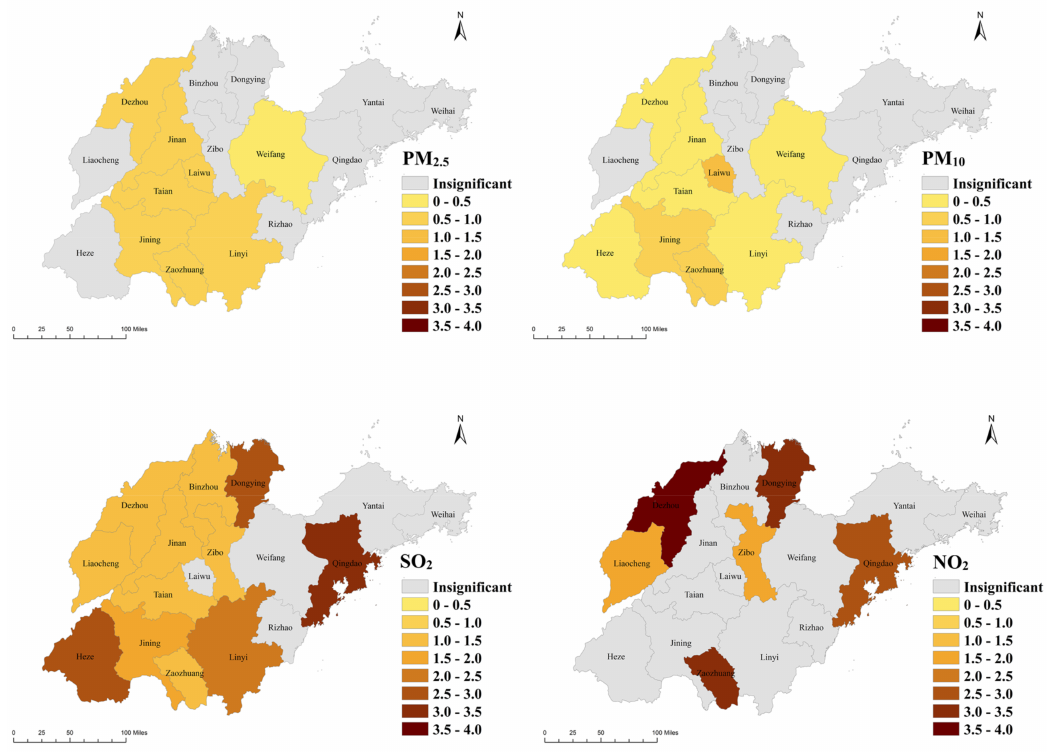
Figure 3. The percentage change in the relative risk of the total COPD hospitalizations per 10- µ g/m 3 increase in air pollution levels in the 17 cities of the Shandong province.